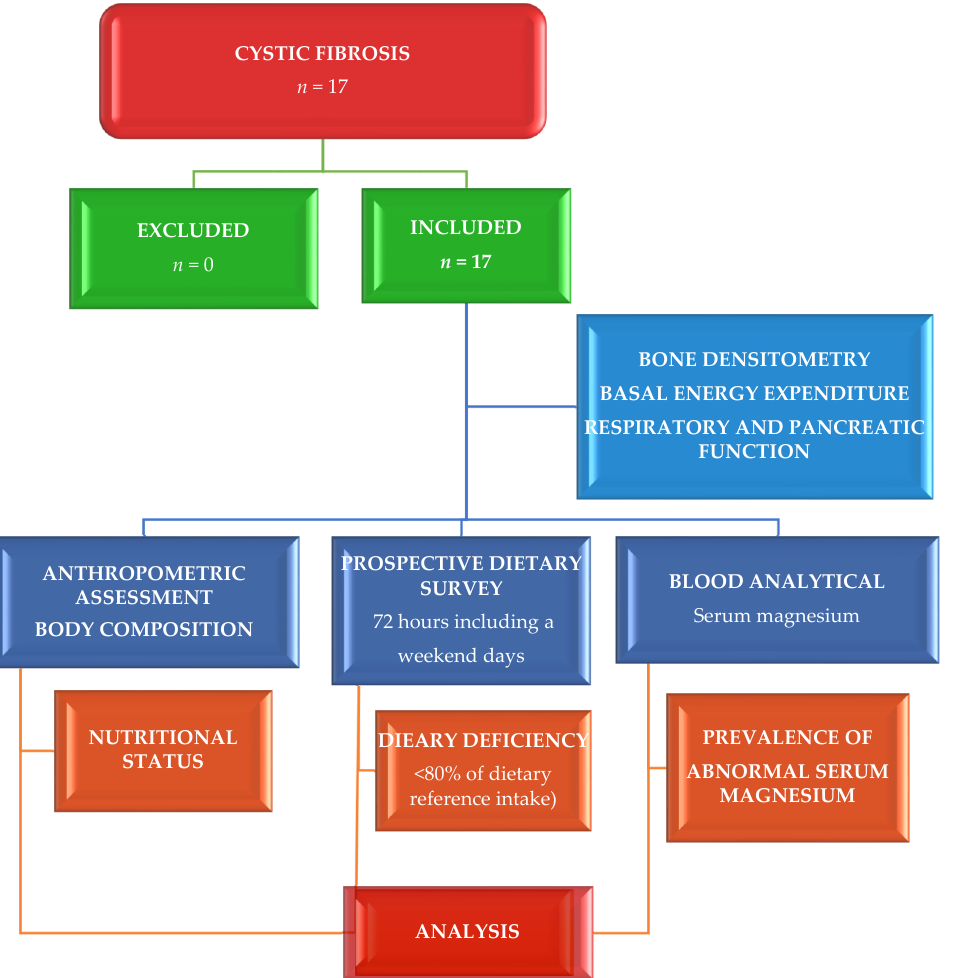
Figure 1. Flow diagram assignment of patients with cystic fibrosis ( n = 17).